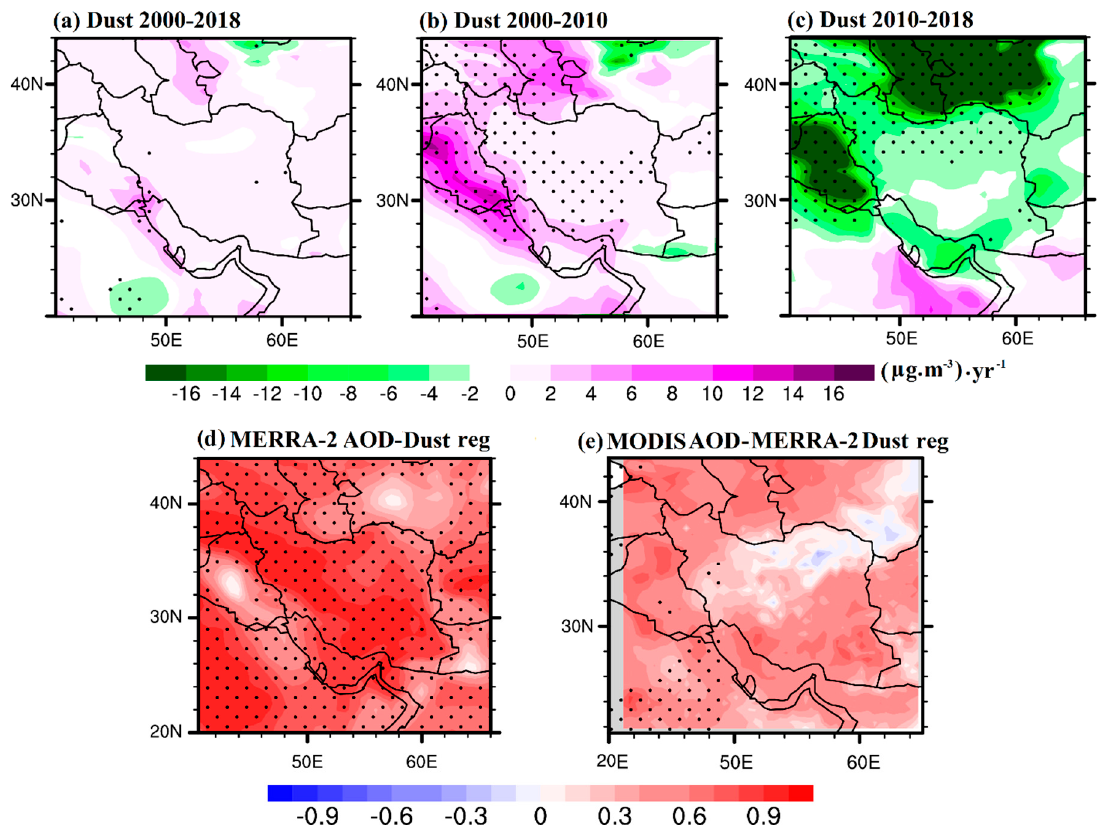
Figure 6. Spatial distributions of the winter (DJF) linear trends of the MERRA-2 dust concentration during the periods 2000–2018 ( a ), 2000–2010 ( b ), and 2010–2018 ( c ), as calculated from the anomalies (DJF) during the period 2000–2018 over Iran. AOD–dust spatial correlations from the MERRA-2 retrievals ( d ) and spatial correlations between the MODIS AOD and MERRA-2 dust ( e ). The black dots indicate that the trends or correlations are significant at a 95% confidence level ( p < 0.05).